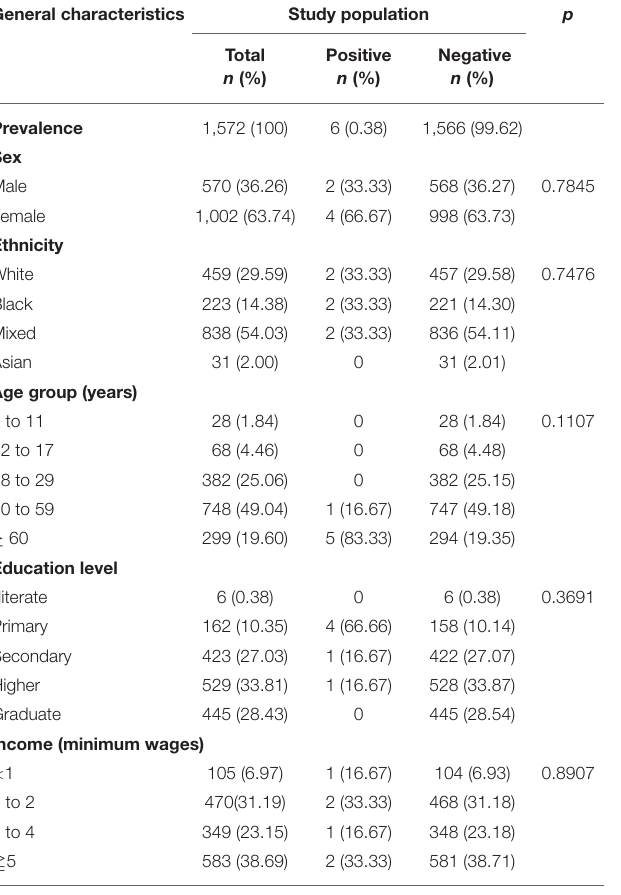
TABLE 1 | General characteristics of the study population. General